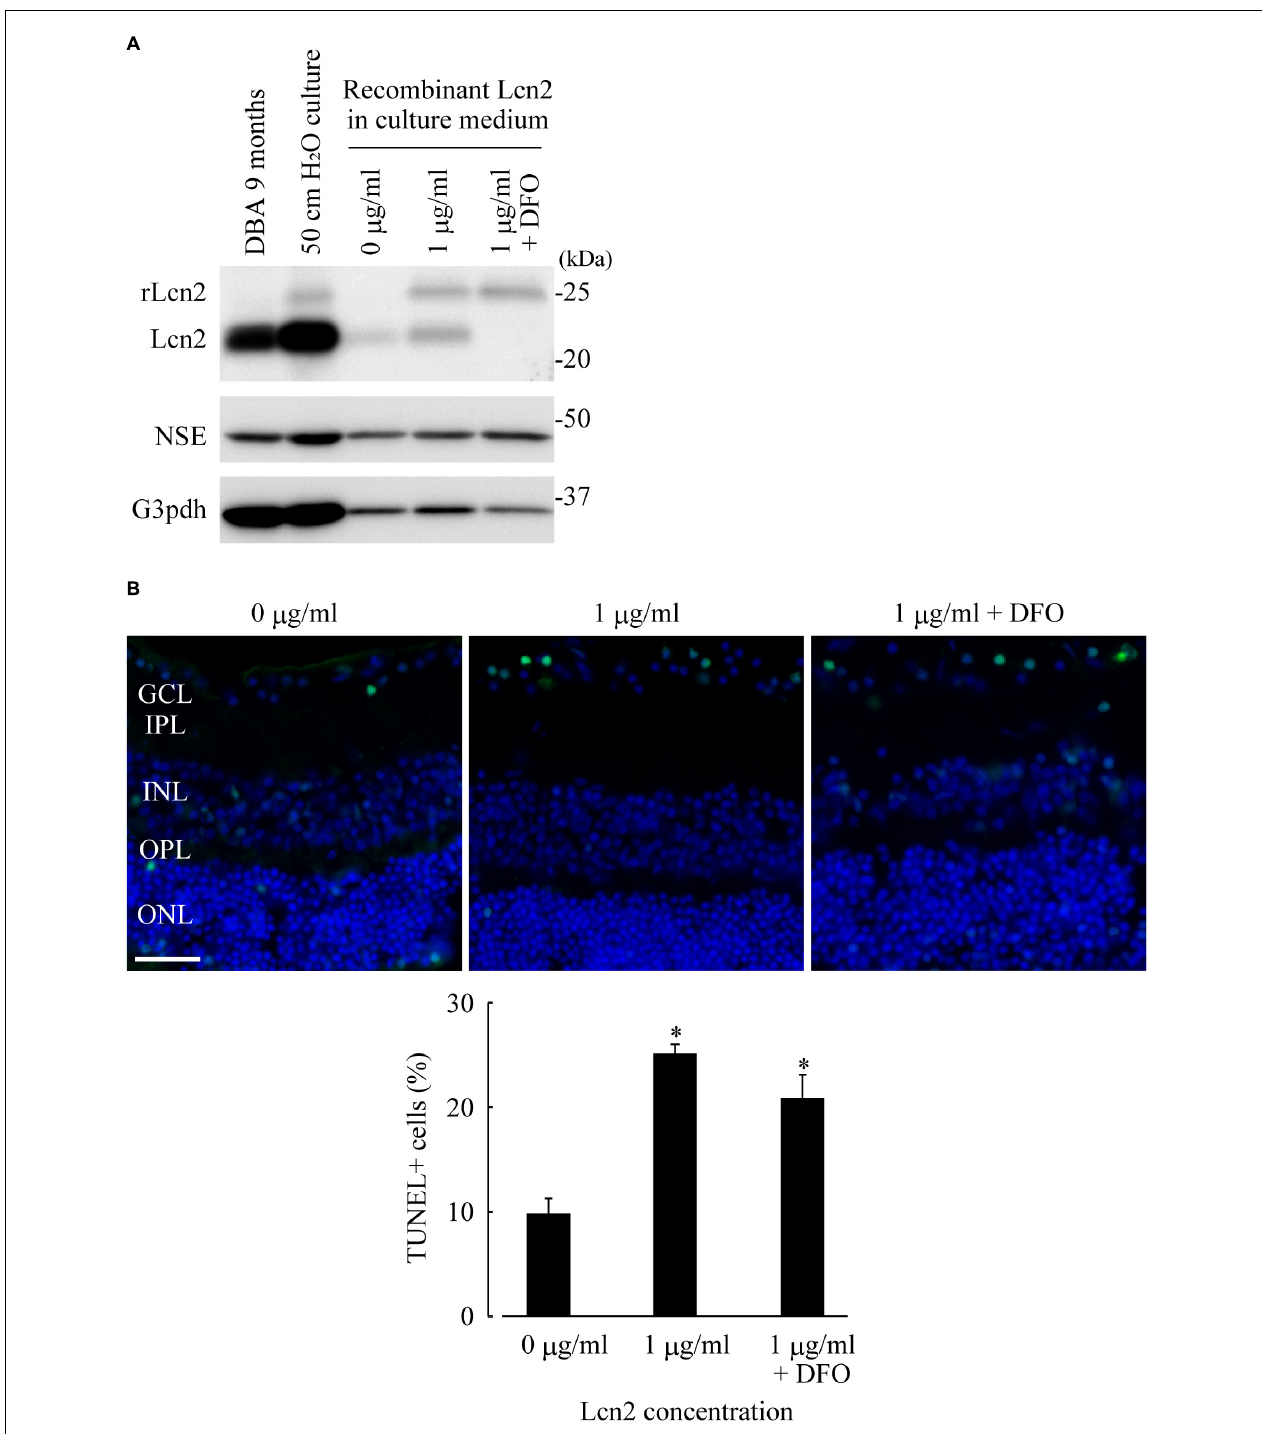
FIGURE 5 | Lipocalin2 (Lcn2)-induced neurotoxicity in RGCs. C57BL/6J mouse retinae were cultured in the culture medium containing 1 µ g/ml of recombinant mouse Lcn2 with or without 100 µ M deferoxamine (DFO). After 16 h of culture, the retinae were subjected to immunoblotting analysis (A) or TUNEL assay (B) . (A) Lcn2 protein levels in the retina of DBA/2J mouse at 9 months of age, the cultured retina under 50 cm pressure, and the cultured retinae under atmospheric pressure with indicated treatment (0 µ g/ml of recombinant Lcn2, 1 µ g/ml of recombinant Lcn2, or 1 µ g/ml of recombinant Lcn2 with 100 µ M deferoxamine) were estimated by immunoblotting. Recombinant Lcn2 protein (rLcn2) appeared larger than native protein in immunoblotting, due to a polyhistidine-tag. (B) TUNEL assay (green) was performed on frozen sections of cultured retinae under atmospheric pressure with indicated treatment. The sections were counterstained with DAPI (blue). Bar = 40 µ m. Graph represents the average percentage of TUNEL-positive cells out of total cells in GCL. * p ≤ 0.05 vs. 0 µ g/ml.